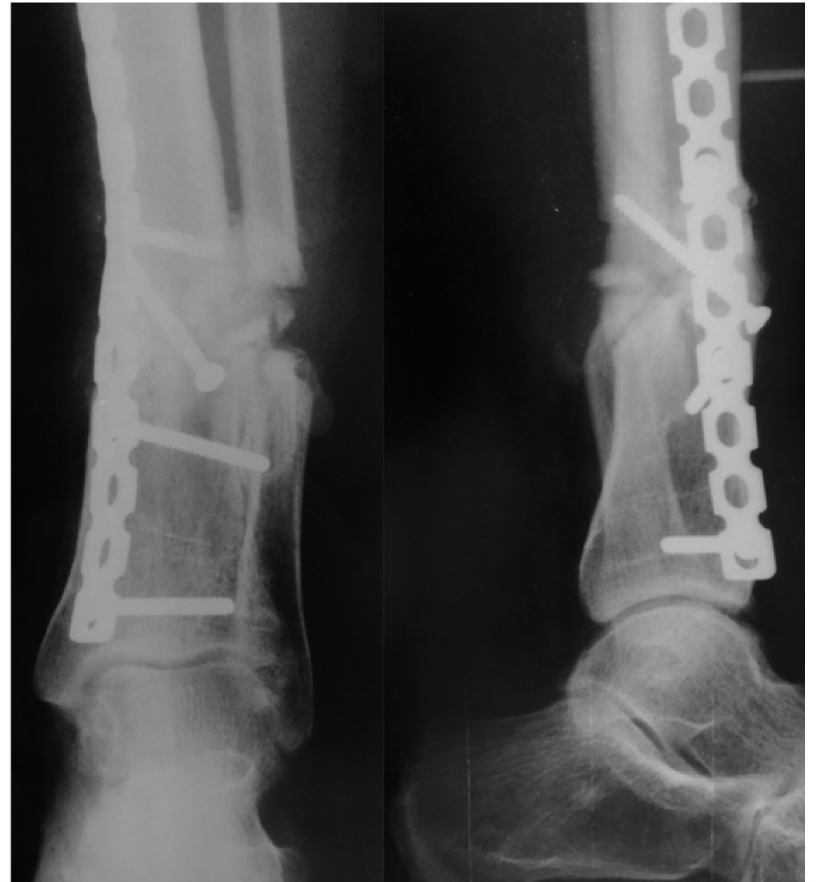
Figure 8. Immediate postoperative radiographic images of the one-stage corrective osteotomy of the malunited fractures. A 2 cm resection of the distal fibula was initially performed, followed by an oblique osteotomy of the distal tibia through an antero-medial